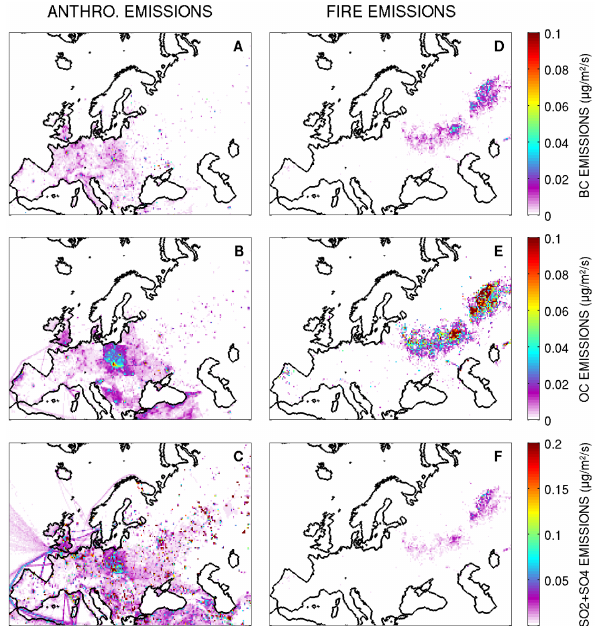
Figure 2. Averaged emissions within the model domain during the simulation period (1 April 2008–12 April 2008) due to anthro- pogenic activities (HTAP v2) and biomass burning (FINN v1). An- thropogenic BC, OC, and SO 2 + SO 4 emissions are shown in (a – c) and biomass burning BC, OC, and SO 2 + SO 4 emissions are shown in (d – f)